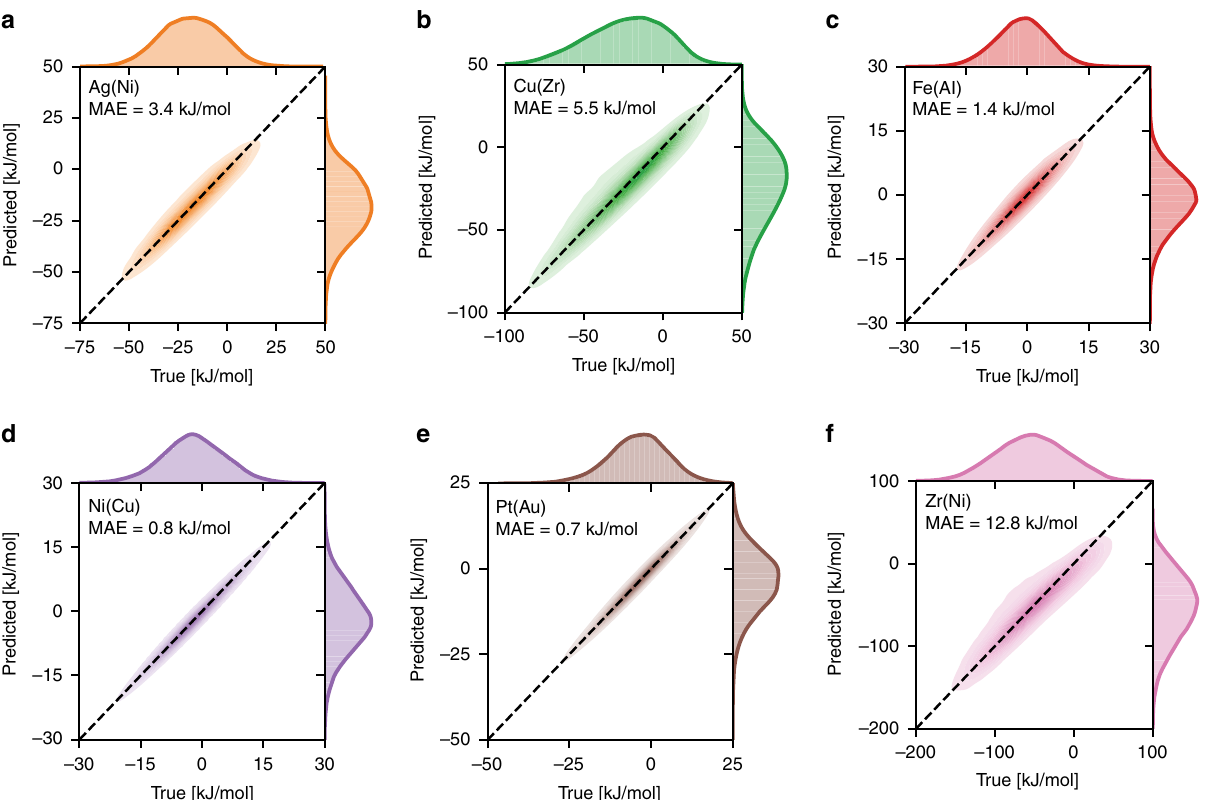
Fig. 2 Validation of the high- fi delity ML framework across the alloy space. The predictive performance — mean absolute error (MAE) – of trained ML models, as outlined in Fig. 1, for solute segregation in six 20x20x20 nm 3 polycrystalline alloys: a – f Ag(Ni) 37 , Cu(Zr) 38 , Fe(Al) 39 , Ni(Cu) 40 , Pt(Au) 41 , and Zr (Ni) 42